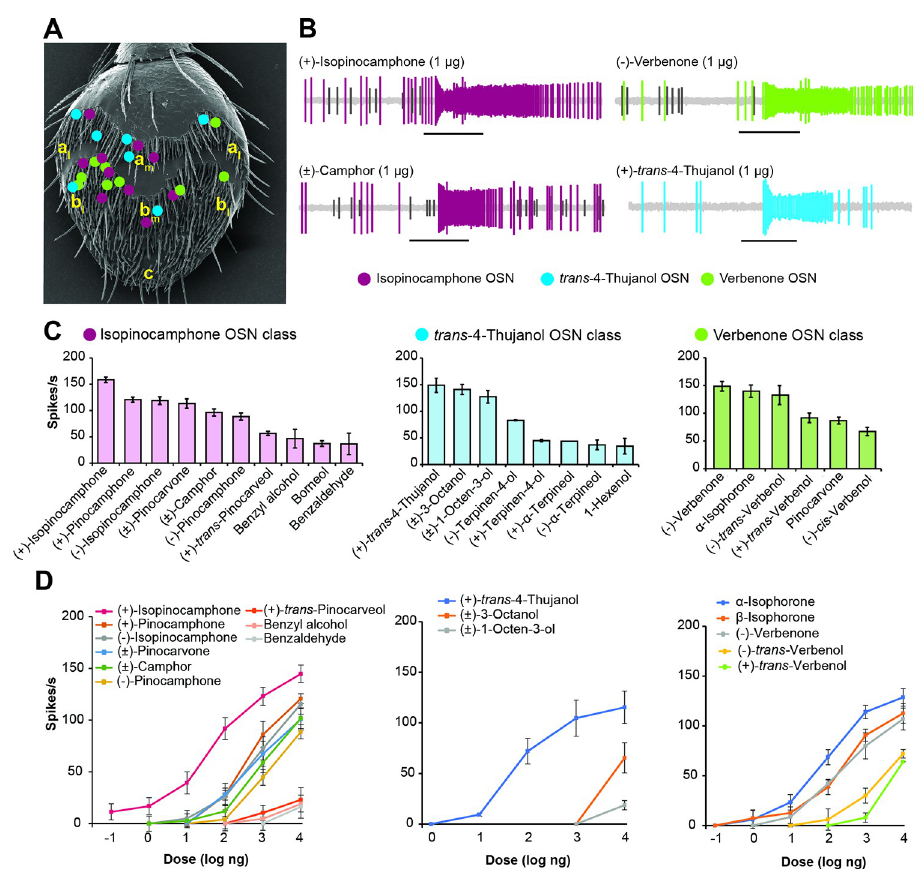
Fig 5. Oxygenated monoterpenes derived from fungal metabolism of host tree monoterpene hydrocarbons are detected by specialized olfactory neurons in the I . typographus antenna. (A) Mapping of three classes of olfactory sensory neurons (OSN) selective for oxygenated monoterpenes (isopinocamphone; verbenone; ( − )- trans -4-thujanol) on the antenna. Olfactory sensilla housing these OSN classes are distributed in medial (subscript “m”) and lateral (subscript “l”) regions of sensillum areas a and b (but not in area c) of the antenna. (B) Representative spike trains from an isopinocamphone-responsive neuron stimulated with 1 μ g of (+)-isopinocamphone (top left) and ( ± )-camphor (bottom left); a verbenone-responsive neuron stimulated with 1 μ g ( − )-verbenone (top right); a (+)- trans -4-thujanol-responsive neuron stimulated with 1 μ g (+)- trans -4-thujanol (bottom right). Black horizontal bars indicate the 0.5-s odor puffs. (C) Response spectra of OSN classes responding predominantly to oxygenated monoterpenes produced by fungi at the 10- μ g screening dose. The average number of spikes/second was recorded from the isopinocamphone-tuned OSN class (left) ( n = 6 except (+) and ( − )-pinocamphone ( n = 3)), trans -4-thujanol- tuned OSN class (middle) ( n = 5), and verbenone and isophorone-tuned OSN class (right) ( n = 4) after neurons were stimulated with a panel of 97 odors. Error bars represent SEM. (D) Dose–response curves of the OSNs stimulated with their most active ligands: isopinocamphone-tuned OSN class (left) (( n = 9) except for (+) and ( − )-pinocamphone ( n = 3)), trans -4-thujanol-tuned OSN class (middle) ( n = 3), and the OSN class tuned to isophorone and verbenone (right) ( n = 3). Error bars represent SEM. The data underlying this Figure can be found at https://doi.org/10.6084/m9. figshare.21692156.v1. (+)-isopinocamphone, ( − )-isopinocamphone, and ( ± )-pinocarvone and weakly to ( ± )-cam- phor, ( − )-myrtenol, trans -pinocarveol, carvone, borneol, and ( − )-fenchone (S10A Fig). The p -cymene OSN class showed intermediate responses to (+)- trans -4-thujanol and carvone (S10B Fig). Although the Δ 3-carene OSN class showed high specificity towards Δ 3-carene, ligands such as camphor and ( − )-isopinocamphone also elicited weak responses from this neuron class (S10C Fig).